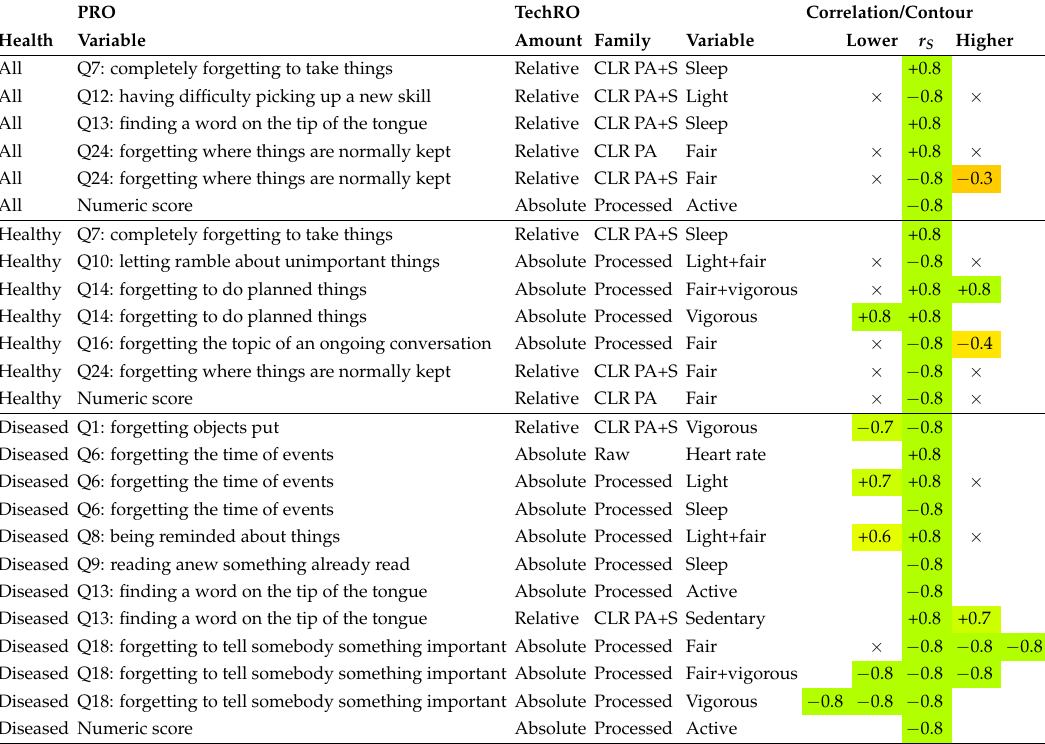
Table 12. Summary of found strong and significant Spearman rank correlations ( r S PROs of memory (MFE scale) and TechROs (Fitbit wearable). PRO TechRO